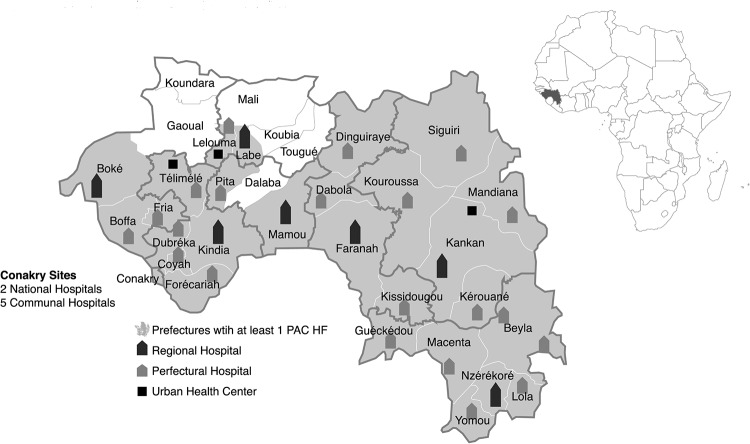
Location and Type of PAC Facilities in GuineaAbbreviations: HF, health facility; PAC, postabortion care.